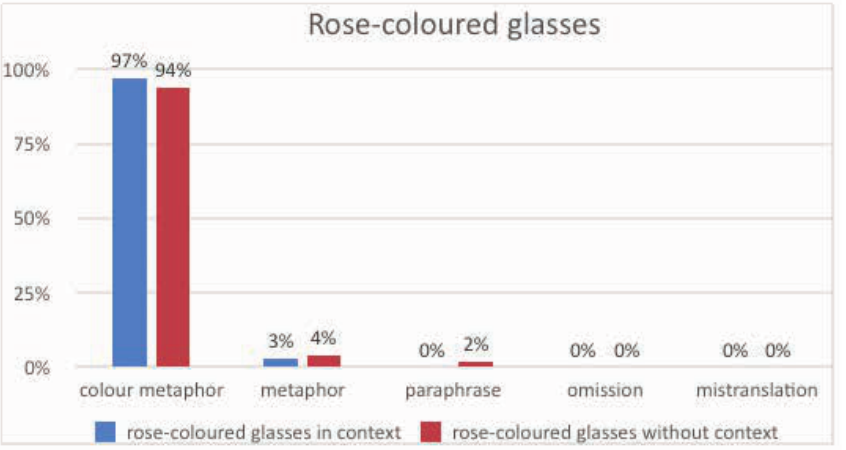
Figure 1: Translation strategies used for translating the colour metaphor rose-coloured glasses in context and without